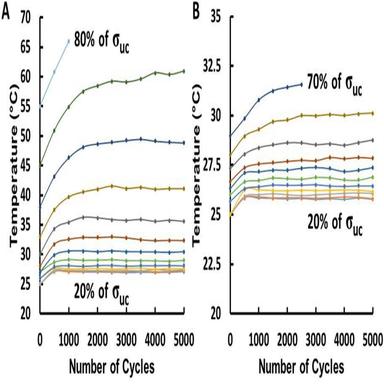
TSA results for the average stabilized temperature vs. number of cycles for the entire range of stresses from 20% to 80% (Type A) or 70% (Type B) of σuc. (A) Type A configuration, (B) Type B configuration.